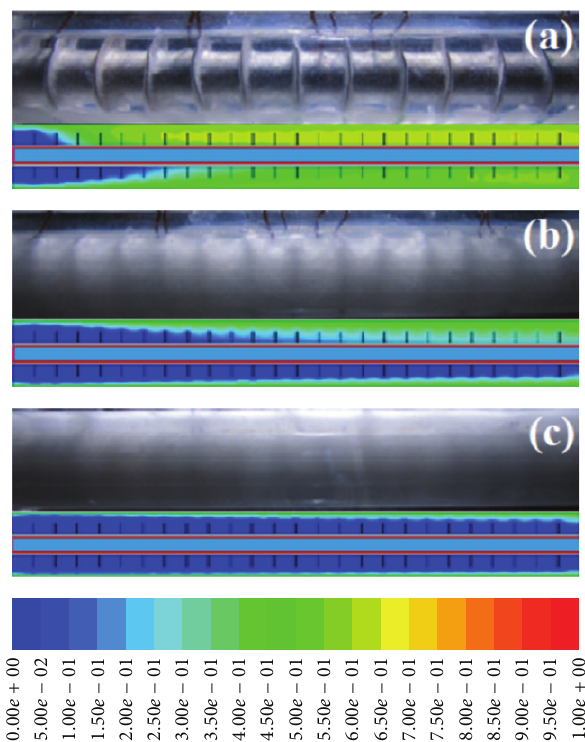
Figure 6: Solidification process for Re = 1000 at (a) 200 s, (b) 1000s, and (c)